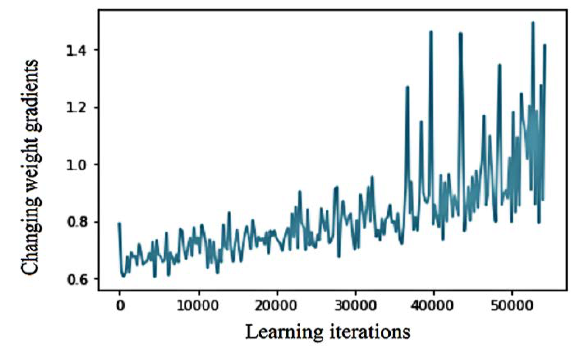
Fig. 3. Graph of increasing changes in the gradients of weights of an artificial neural network